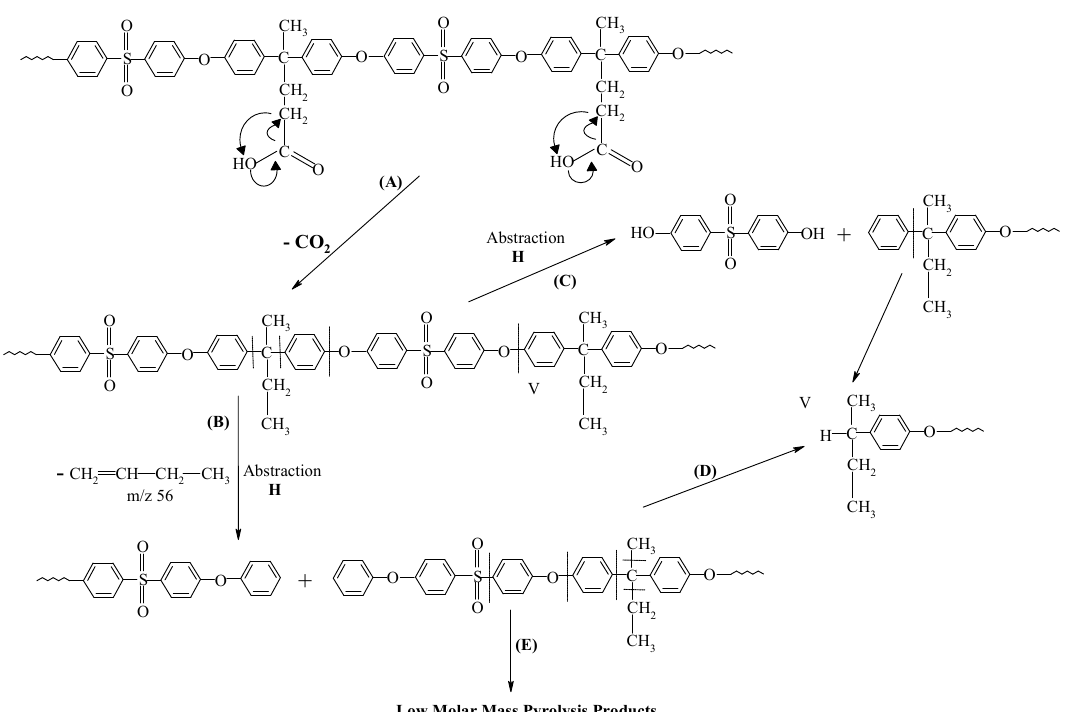
Scheme 4. Thermal-degradation mechanisms involving the ESDPA sequences: ( A ) decarboxylation process; ( B ) multiple cleavage of phenyl-alkyl (Ph–C) bonds; ( C ) scission of phenyl-ether (Ph–O) bonds; ( D ) cleavage of Ph–O and Ph–C bonds; ( E ) cleavage of alkyl-alkyl (C–C) bonds, phenyl–O bond and phenyl–SO 2 bond. Polymers 2020 , 12 , x